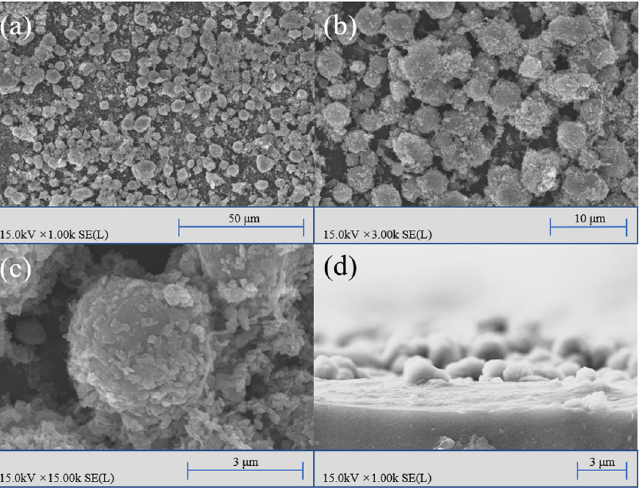
Figure 2. SEM images of the biomimetic superhydrophobic film surface modified by F 16 CuPc with different magnifying factors, ( a ) 1 k, ( b ) 3 k, and ( c ) 15 k, and ( d ) the cross-section image of the F 16 CuPc-modified biomimetic superhydrophobic film.